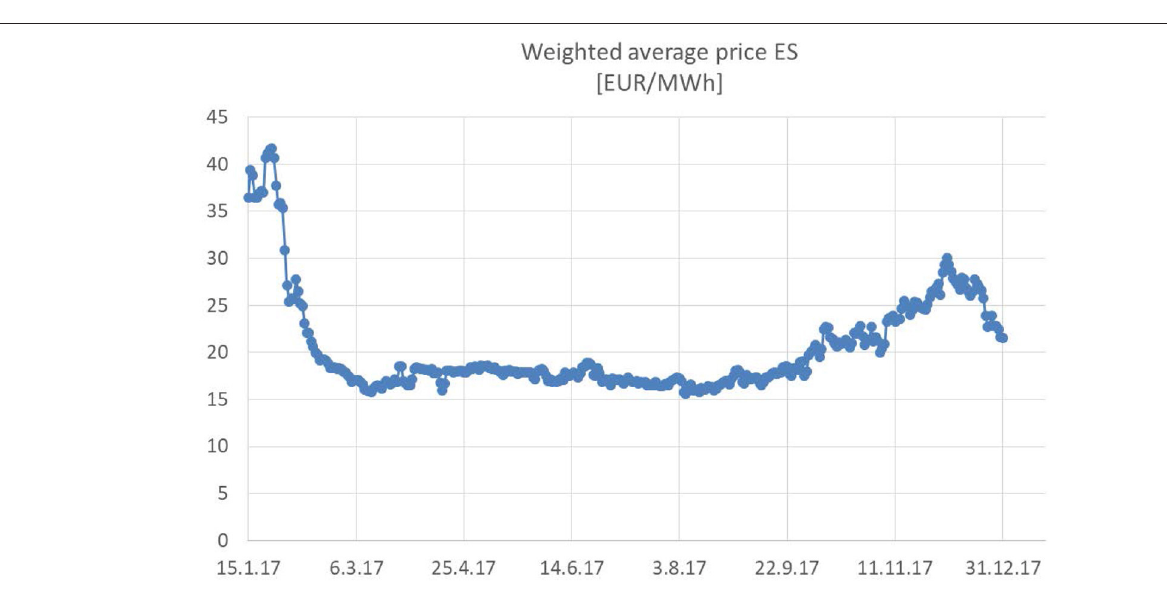
FIGURE 3 | Average market natural gas price into the Iberian market (MIBGAS,